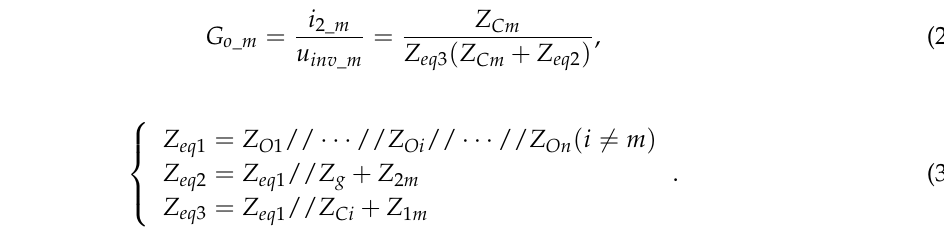
Figure 2. Implified model of LCL filter network for G o_m .